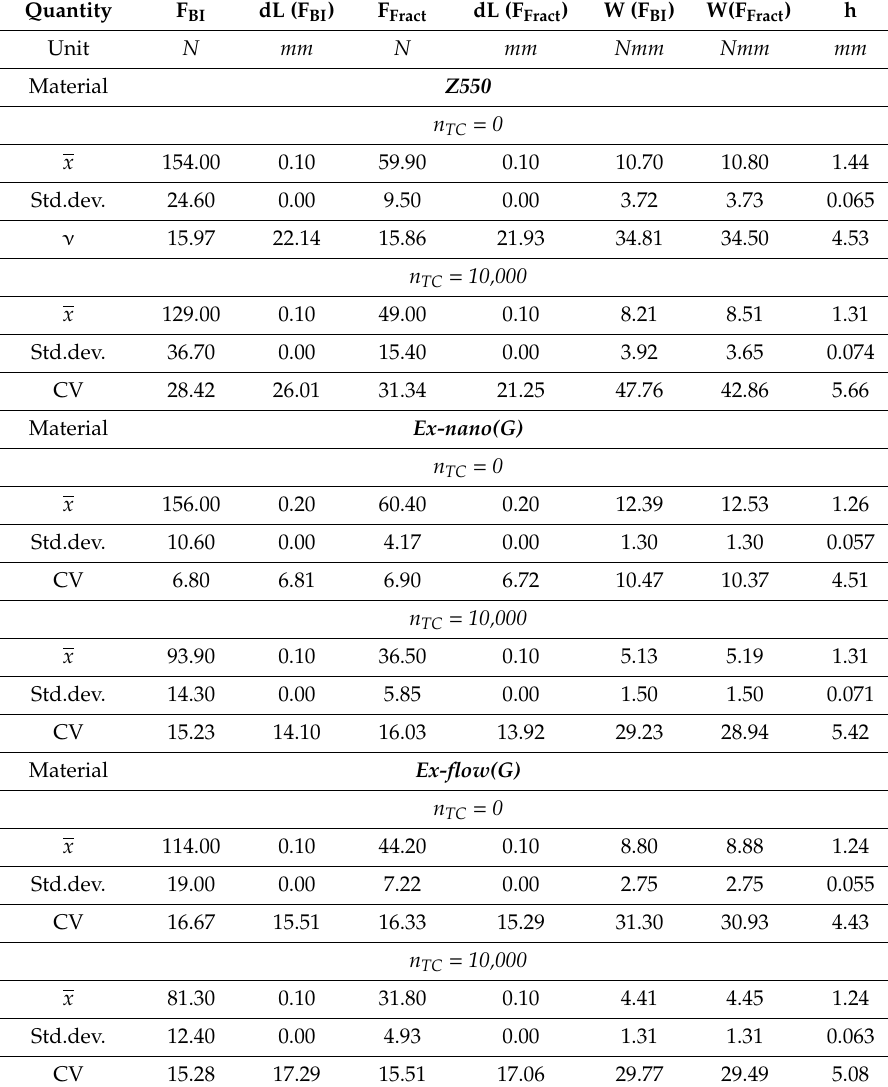
Table 2. Descriptive statistics of the results obtained in the BFS test.